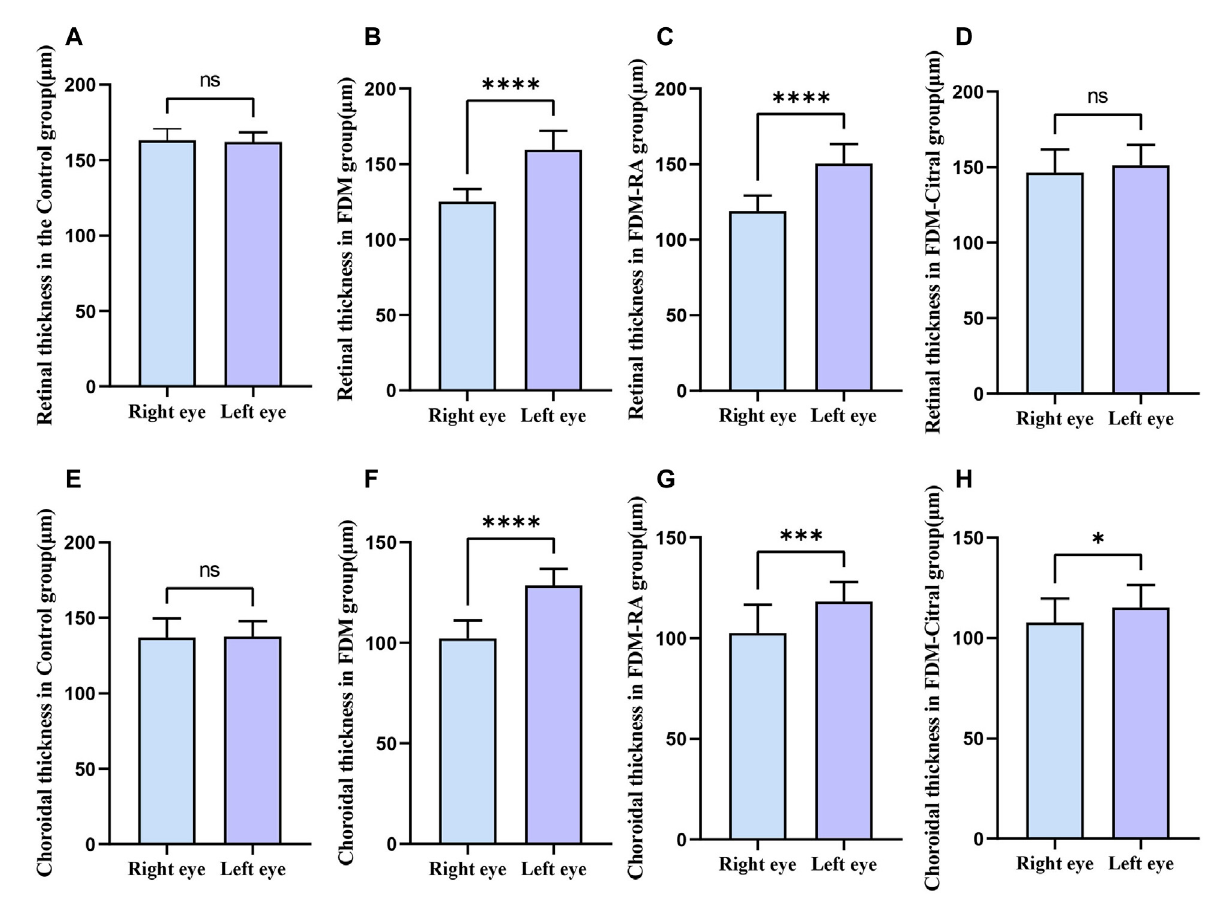
FIGURE 8 Comparison of RT and CT between the left and right eyes in each group ( μ m). Note. (A) , Comparison of RT between left and right eyes in Control group; (B) , Comparison of RT between left and right eyes in FDM group; (C) , Comparison of RT between left and right eyes in FDM + RA group; (D) , Comparison ofRTbetweenleftandrighteyesinFDM+Citralgroup; (E) ,ComparisonofCTbetweenleftandrighteyesinControlgroup; (F) ,Comparison of CT between left and right eyes in FDM group; (G) , Comparison of CT between left and right eyes in FDM + RA group; (H) , Comparison of CT between leftand right eyesinFDM + Citral group;ns meansthat thedifference isnot statistically signi fi cant;*Indicates p ≤ 0.05; **Indicates p ≤ 0.01; *** Indicates p ≤ 0.001; **** Indicates p ≤